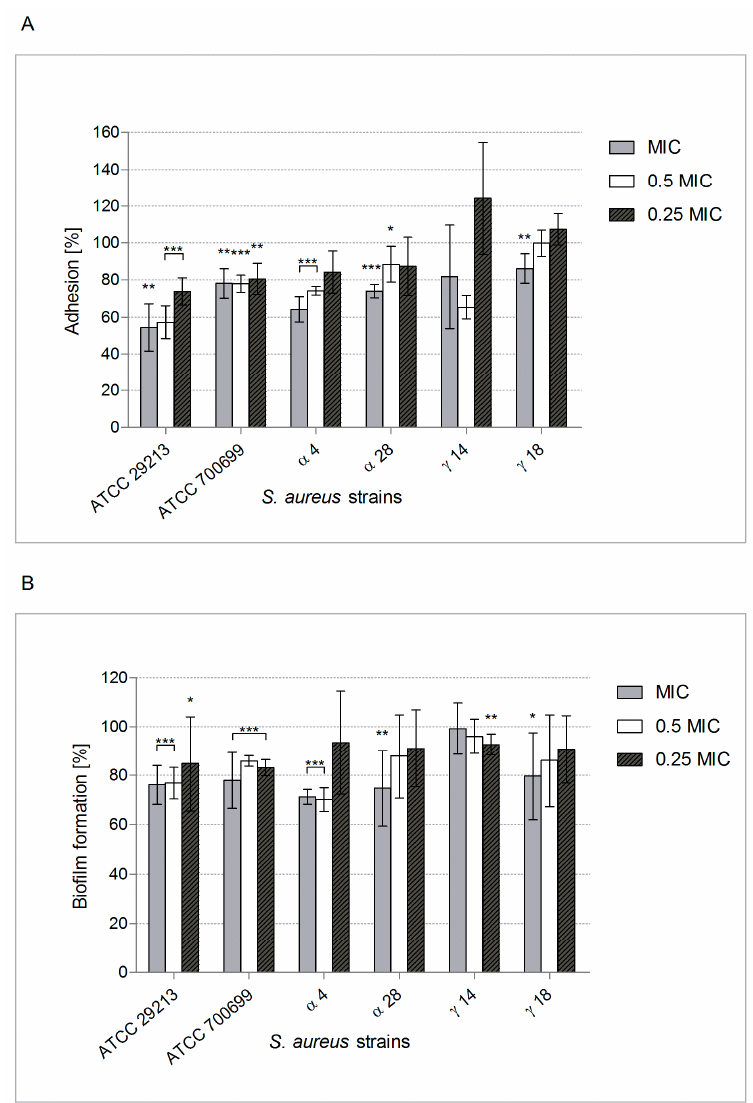
Figure 3. Adhesion ( A ) and biofilm formation ( B ) by S. aureus reference and clinical strains (n = 2 + 4) on elastin-conditioned surface, in the presence of POE used at MIC, 0.5 × , 0.25 × MIC, tested by LIVE/DEAD BacLight Bacterial Viability Kit. The percentage of adhered cells or biofilm biomass compared with positive control (untreated bacteria) considered as 100% is presented. Significant differences: * p ≤ 0.05, ** p ≤ 0.01, *** p < 0.001.